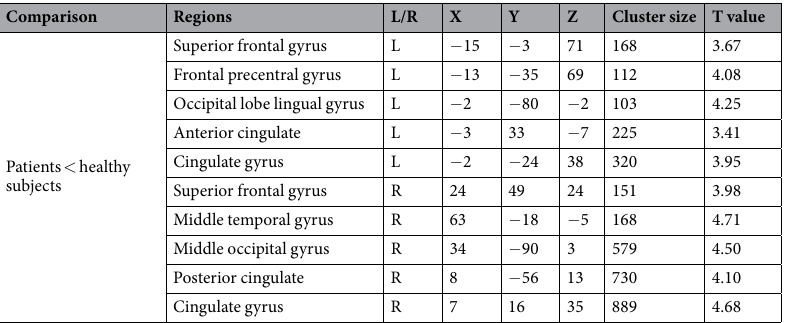
Table 4. Decreased gray matter volume in patients with adult-onset, drug-naive first-episode